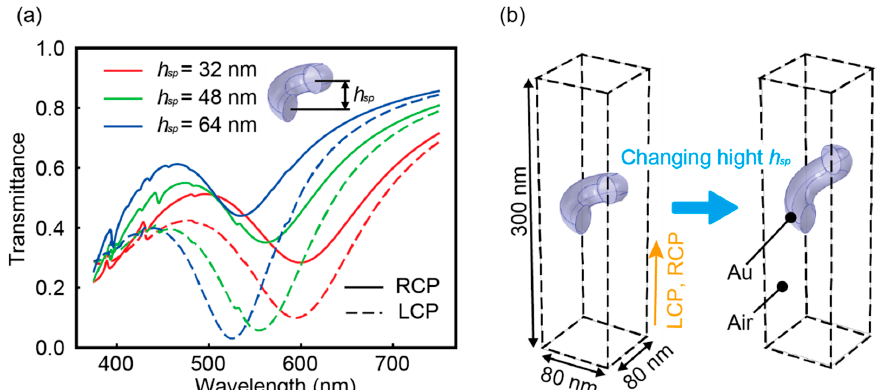
Figure 8. One unit cell of the Au nanospiral structure is modelled with periodic boundary conditions to simulate an infinite 2D array. The right circularly polarized (RCPs) and left circularly polarized (LCPs) were illuminated through the lower port of the unit cell and the transmitted light intensity was acquired at the upper port of the unit cell. ( a ) Transmission spectra of the Au nanospiral structures as a function of height h sp . ( b ) An overview of the unit cell containing the Au nanospiral structure.